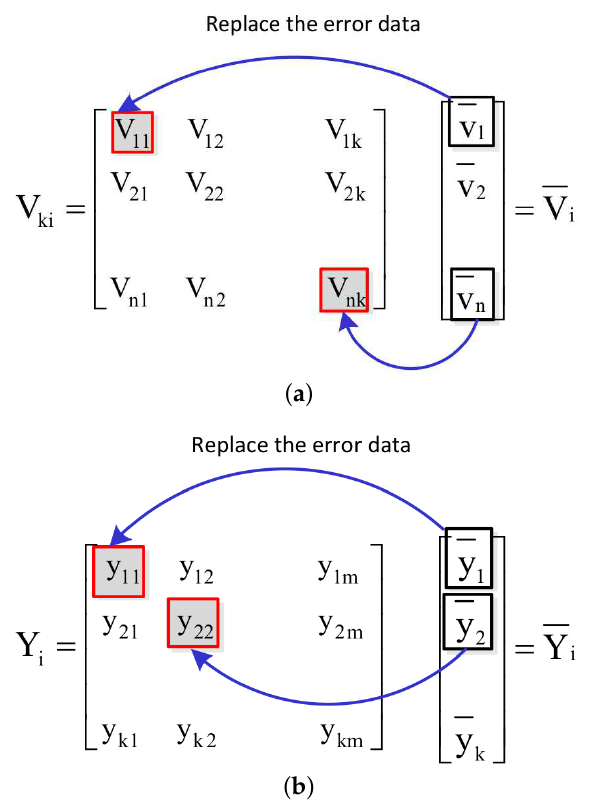
Figure 6. Correcting erroneous data with the average vectors. ( a ) Correcting error in the eigenvectors V Ki with average vector V i , ( b ) Correcting error in the projection data Y i with average vector Y i